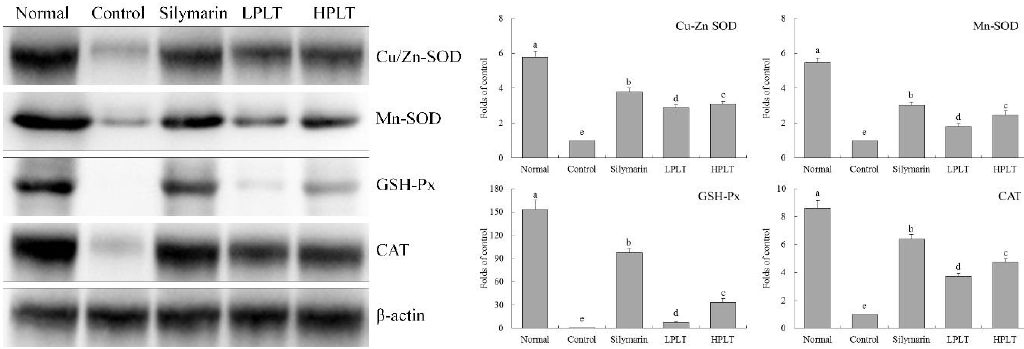
Figure 3. Cu/Zn-SOD, Mn-SOD, GSH-Px, and CAT protein expressions in hepatic tissue of experimental mice with CCl 4 -induced hepatic damage. Values presented are the means ± standard deviation ( N = 3/group). a – e Mean values with different letters in the same bars are significantly different ( p < 0.05) and those with the same letter in the same column are not significantly different ( p > 0.05) according to Duncan’s new MRT. Silymarin group: 50 mg/kg b.w. silymarin treatment dose; LPLT group: 50 mg/kg b.w. polyphenols of Liubao tea (PLT) treatment dose; and HPLT group: 100 mg/kg b.w. polyphenols of Liubao tea (PLT) treatment